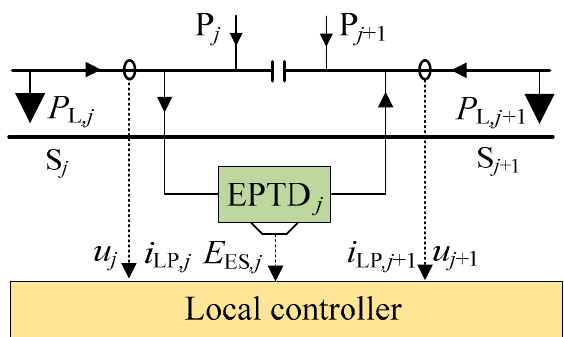
Figure 18. The data information needed to be detected in decentralized control of the EPTD.